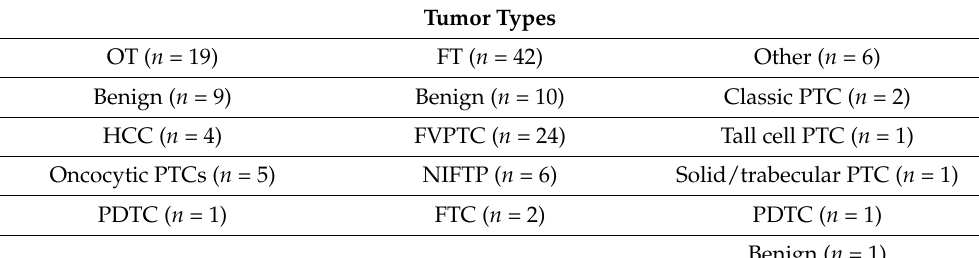
Table 6. Tumor types according to the final histopathology of all the 67 CNA-positive thyroid